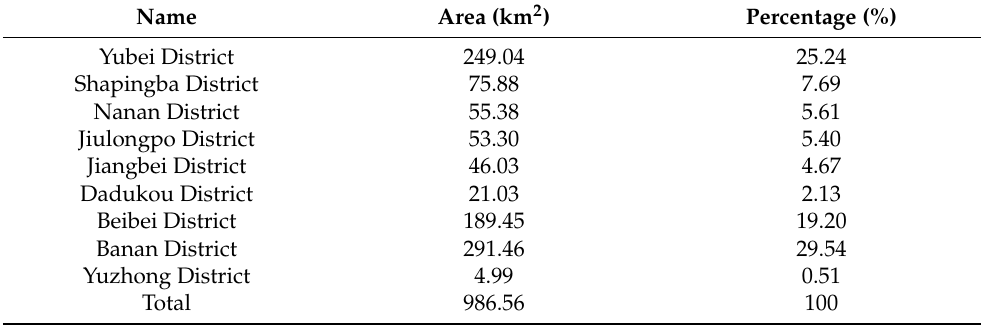
Table 7. Ecological source area statistics.